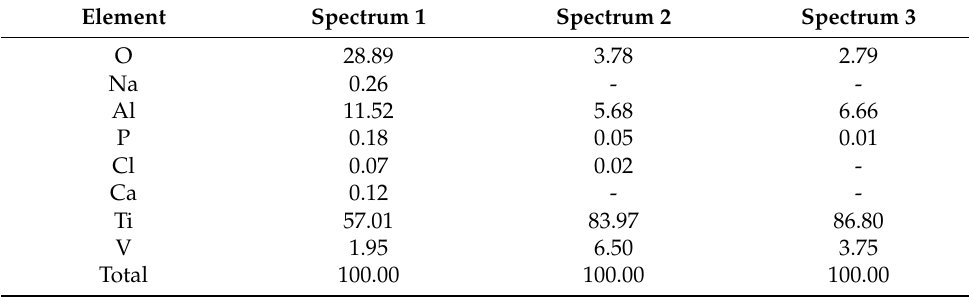
Figure 10. SEM image of Ti-6Al-4V alloy after impedance measurements in PBS solution with marked spots of EDS analysis. Table 7. Elemental composition of Ti-6Al-4V alloy on different spots (position 1–3) on surface Ti-6Al-4V alloy after impedance measurements in PBS solution .